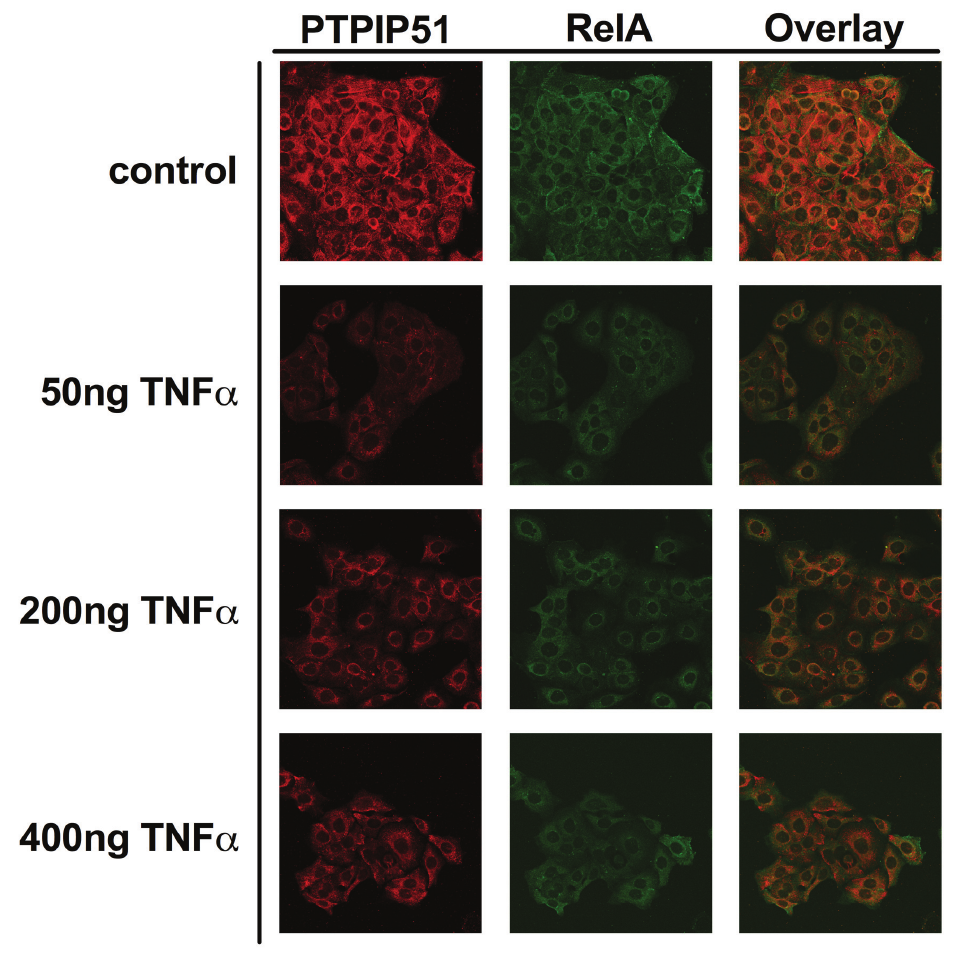
Figure 3. Immunocytochemical staining of PTPIP51 and RelA in human keratinocytes. Upper panel: untreated controls: PTPIP5, RelA, overlay. Second panel: 50 ng/mL TNF(cid:3) treated cells: PTPIP51, RelA, overlay. Third panel: 200 ng/mL TNF(cid:3) treated cells: PTPIP51, RelA, overlay. Fourth panel: 400 ng/mL TNF(cid:3) treated cells: PTPIP51, RelA, overlay. Co-localization is indicated by organge